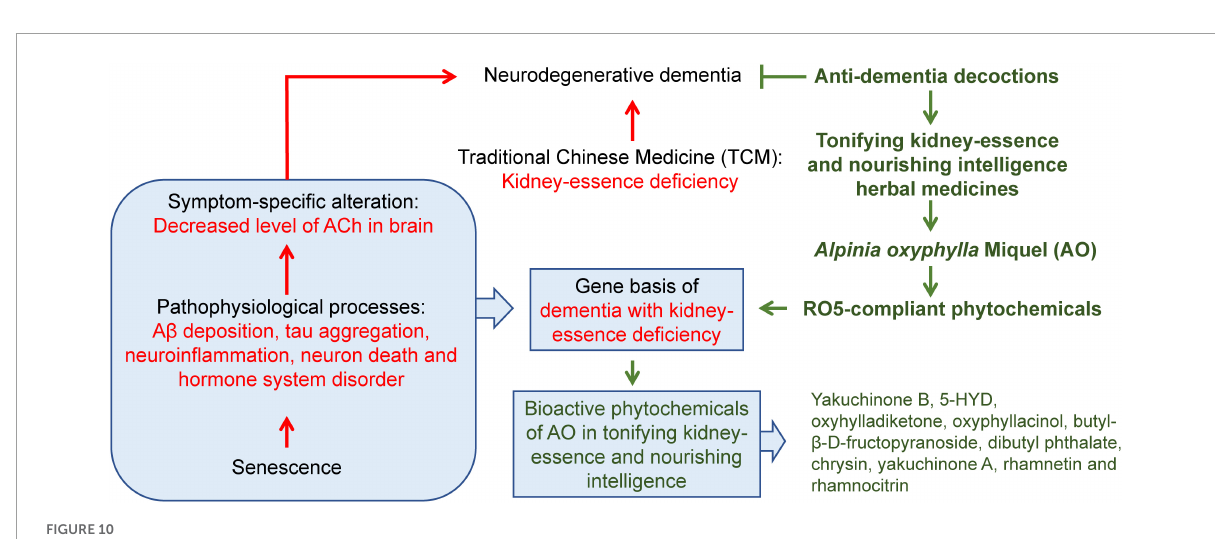
FIGURE10 A schematic diagram of the overall conclusion of this